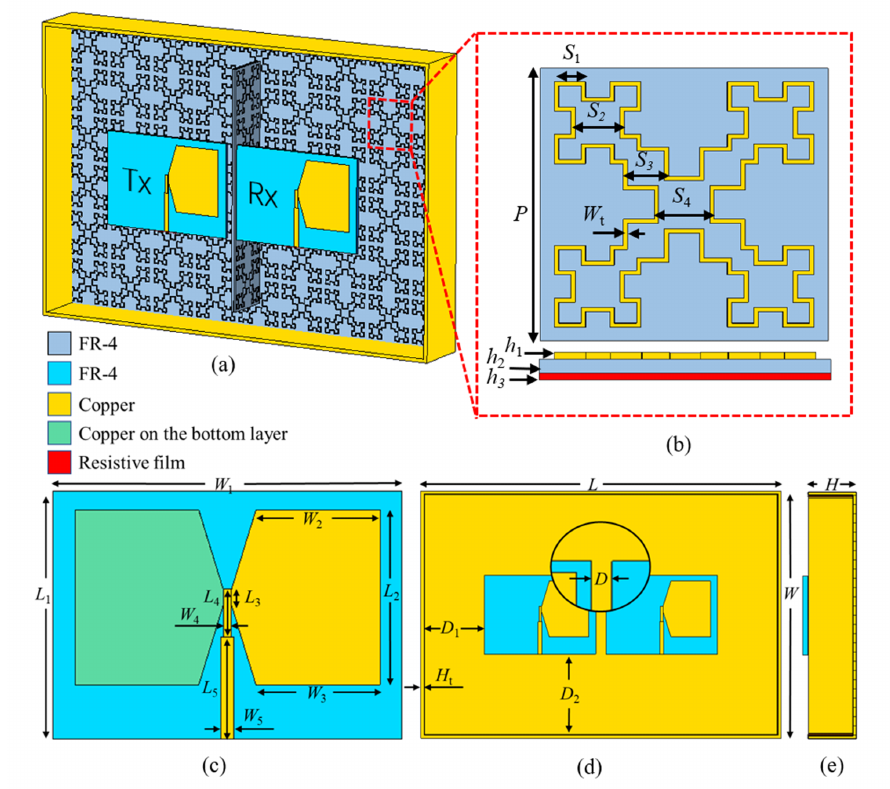
Figure 2. The proposed GPR transceiver antennas. ( a ) the overall structure. ( b ) the MMA unit. ( c ) the design of the bow-tie antenna. ( d ) the top view of the transceiver antennas with back-cavity. ( e ) the side view of the transceiver antennas with